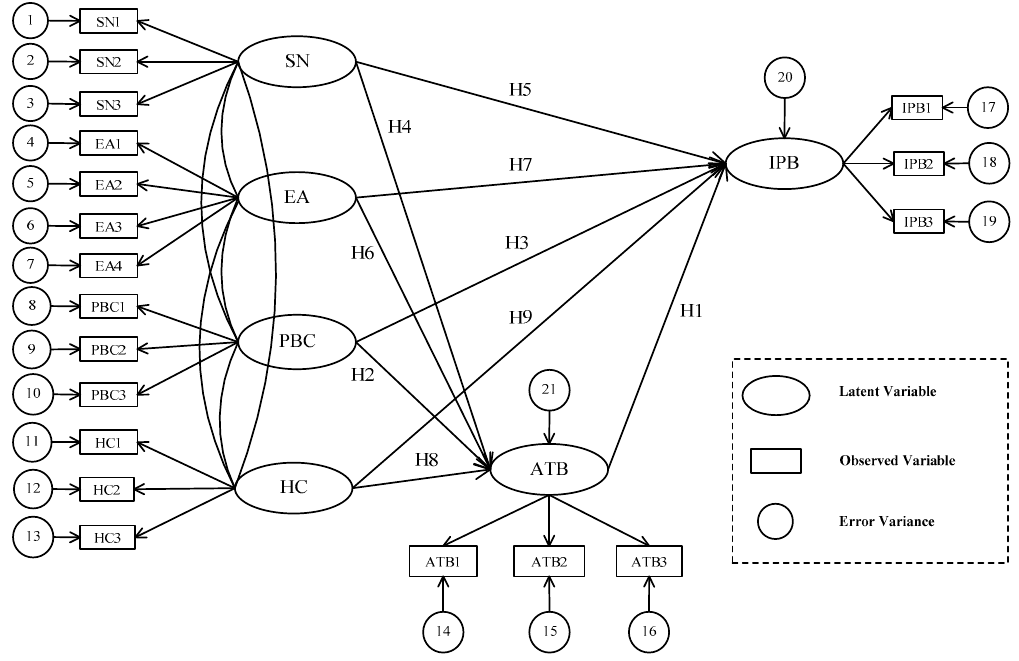
Figure 2. Conceptual Framework. SN: subjective norm. EA: environmental awareness. PBC: perceived behavioral control. HC: health consciousness. IPB: intentional purchasing behavior. ATB: attitude towards the behavior. H: hypothesis.